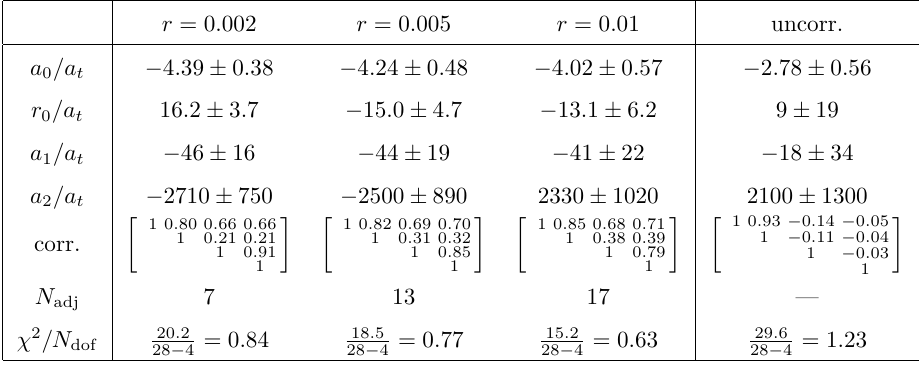
Table 14 . As table 11 but for D ¯ K I = 1 on the m π = 391 MeV ensembles, eq. (5.15). Open